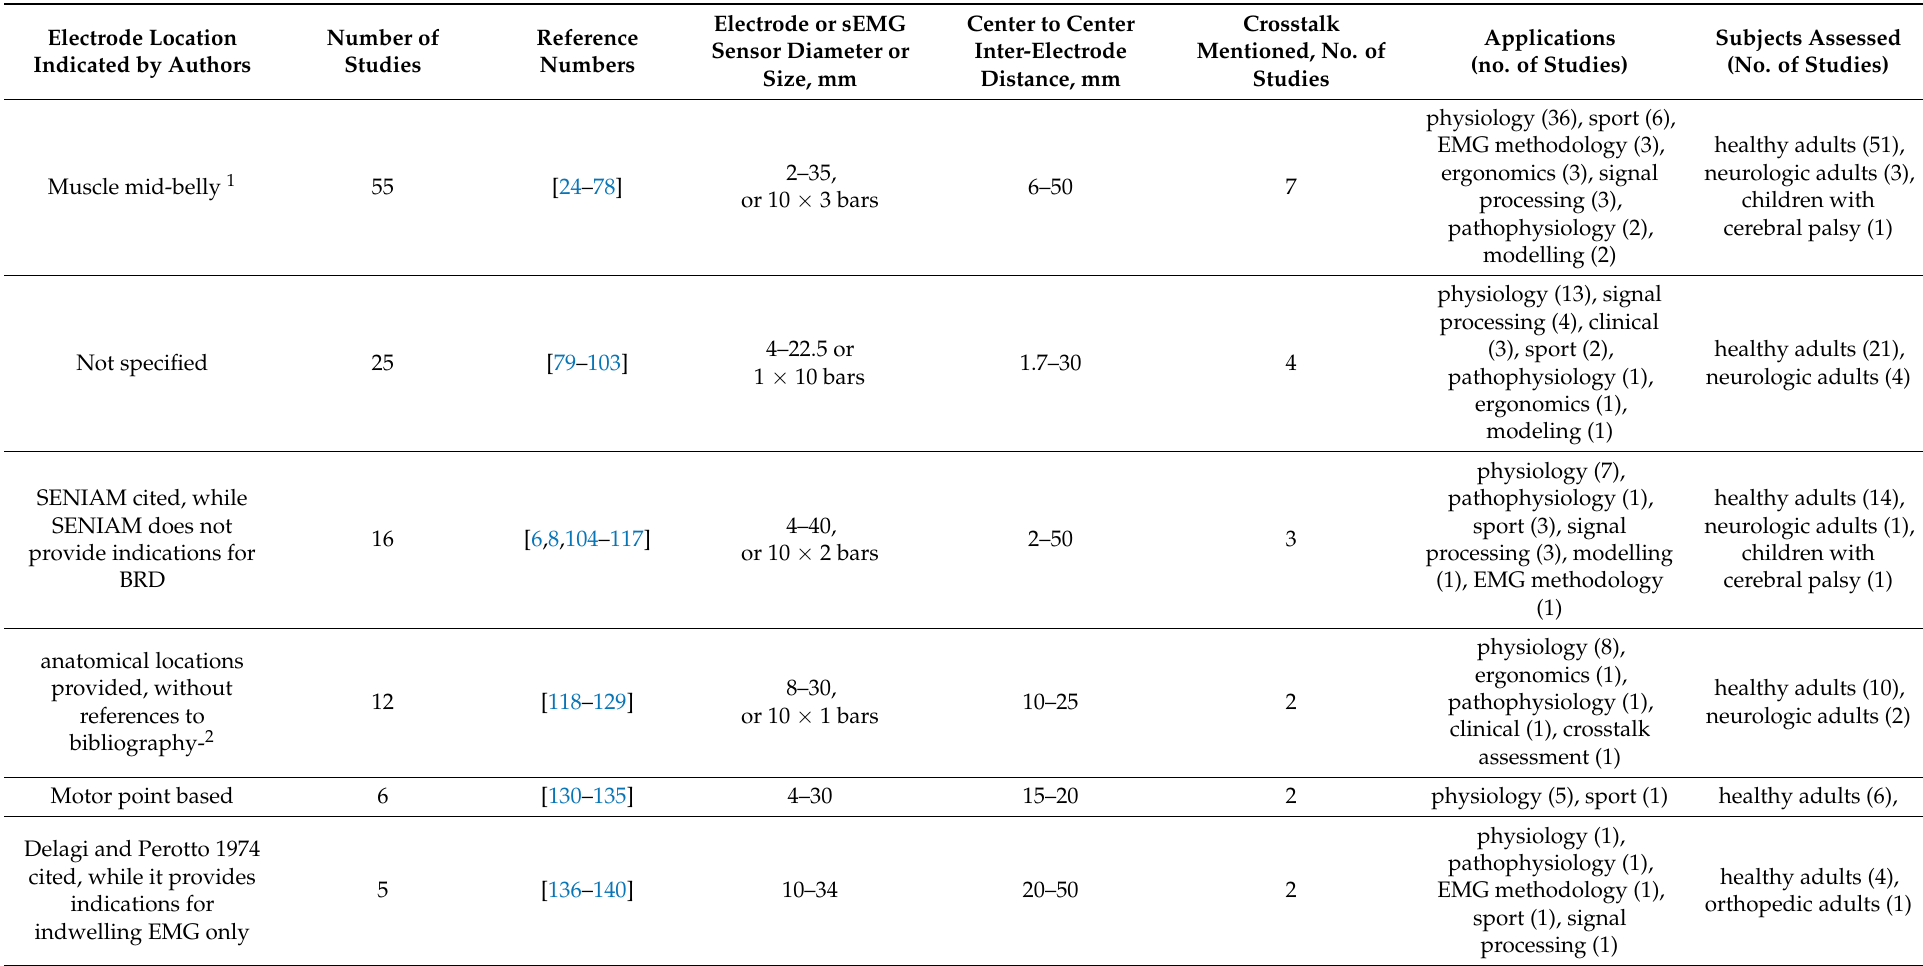
Table 3. Electrode configuration and characteristics of the studies assessing brachioradialis muscle activity by bipolar sEMG, as reported in the studies included in this review. Electrode